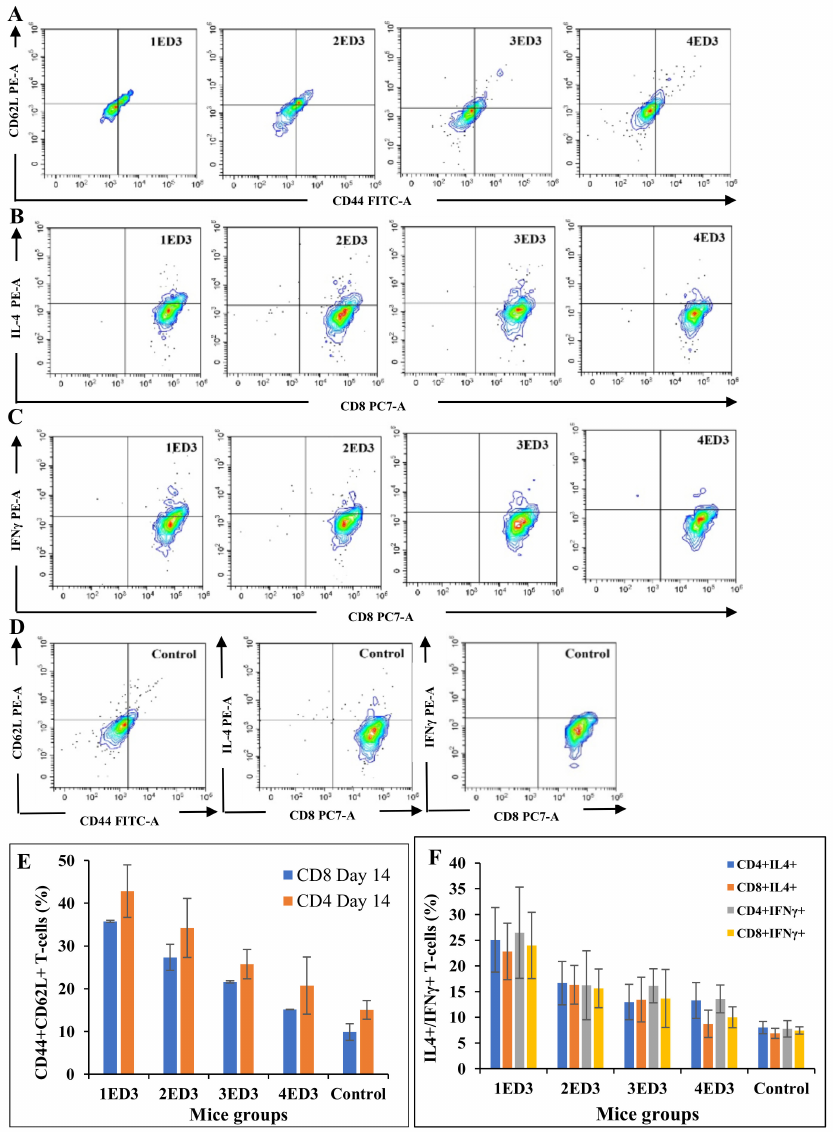
Figure 3. Effects of ED3 immunization on T-cell memory status in BALB/c mice. The CD44-CD62L co-expression at day 14 ( A ), IL-4 expression at day 7 ( B ), and IFN- γ expression at day 7 ( C ) by T C cells are shown. Expression of CD44/CD62L, IL-4, and IFN- γ in unimmunized control mice ( D ). The relative percentages of CD44 + CD62L + T cells, and percentages of T cells expressing IL-4 and IFN- γ in ED3 immunized mice are shown in panels ( E , F ), respectively. The 1ED3 immunization resulted in the highest co-expression of CD44 and CD62L on T cells with the highest intracellular expression of IL-4 and IFN- γ by T cells, followed by 2ED3, 3ED3, and 4ED3 immunizations. These results suggested that 1ED3 was the most immunogenic while DENV4 ED3 was the least immunogenic